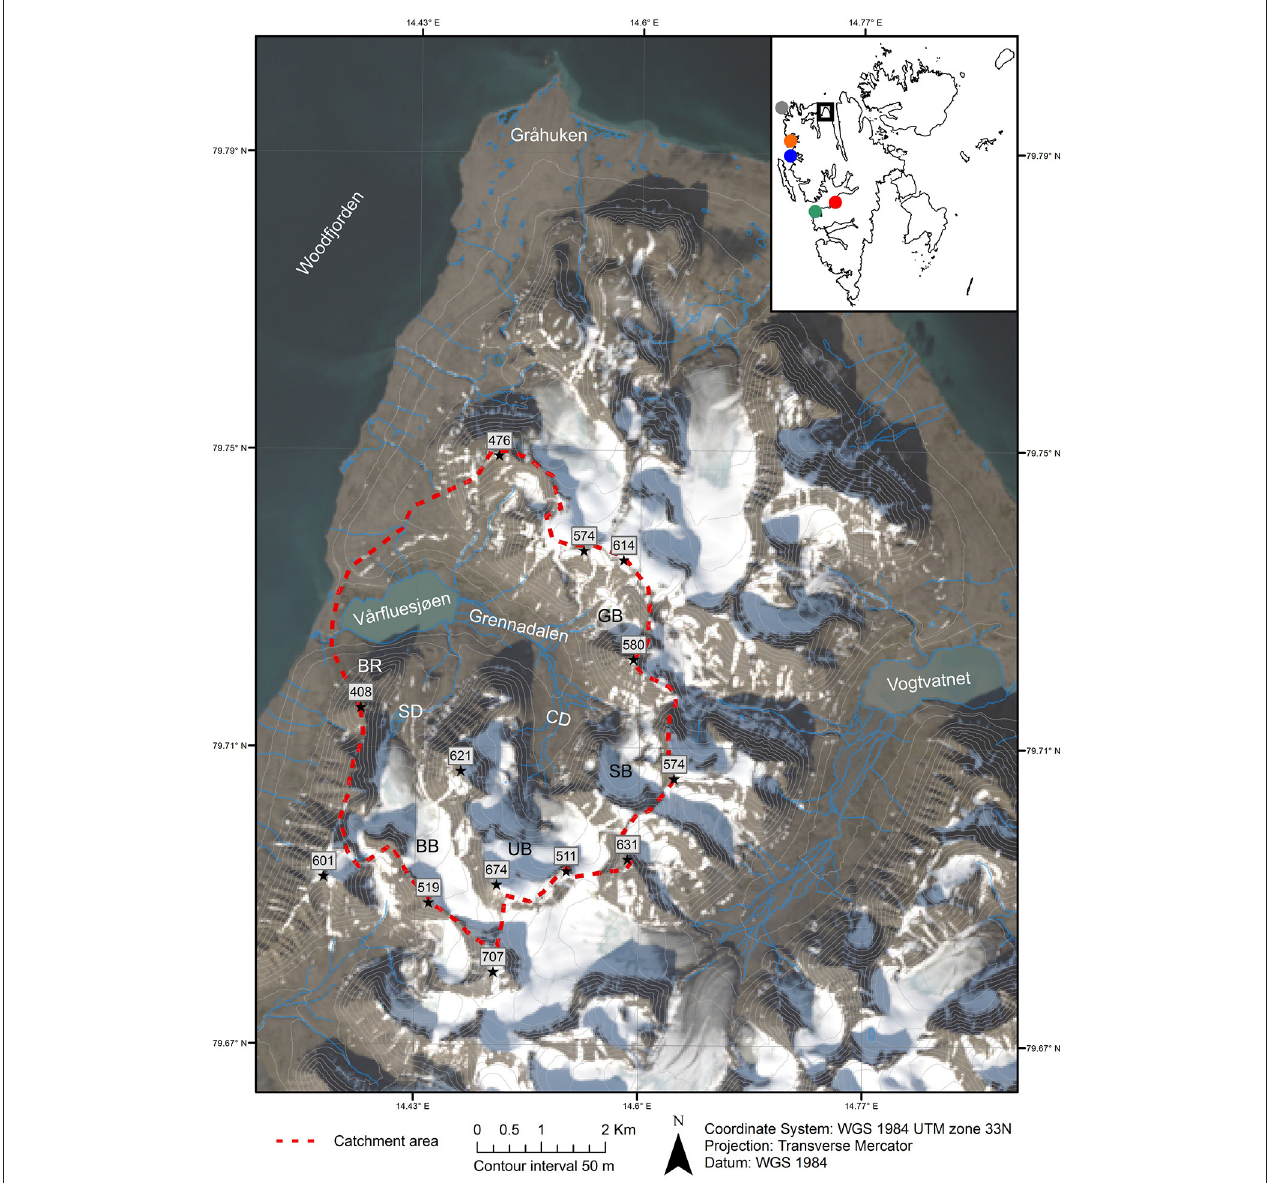
FIGURE 1 | Overview photo of Andrée Land Peninsula, showing the study area within the red dashed line. Glaciers in the catchment area are abbreviated as follows: BB, Bybreen; UB, Uglebreen; SB, Salamonbreen; and GB, Grennabreen. Numbers in white correspond to height above sea level. Three valleys are joined at Vårfluesjøen: Grennadalen, Stratusdalen (SD), and Cirrusdalen (CD). In the west, we find the mountain range Bråvallafjella (BR). The smaller inlet map shows the Svalbard archipelago, and the black square indicates where the study area is located. Dots refer to sites mentioned in the text: gray, Amsterdamøya; orange, Mitrahalvøya (Karlbreen); blue, Ny-Ålesund; green, Isfjord Radio/Linnedalen; red, Longyearbyen and